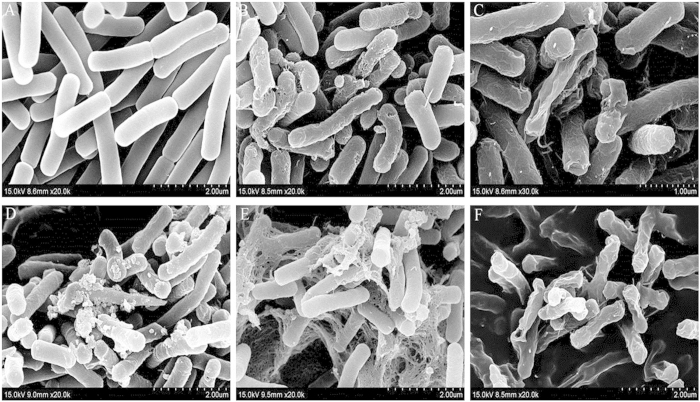
SEM micrographs of E. coli ATCC 25922: (A) Control; (B) GG2-treated; (C) GG3-treated; (D) AA2-treated; (E) AA3-treated; (F) Melittin-treated. Bacteria were treated with centrosymmetric peptides at 1 × MBC for 1 h. The control was processed without centrosymmetric peptides.